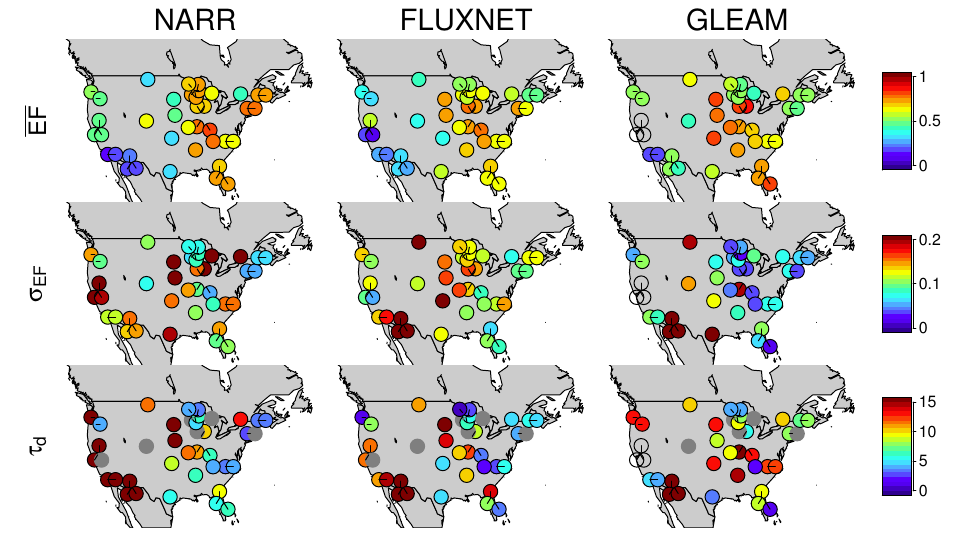
Figure 6. Statistical properties of EF data sets (NARR, FLUXNET, GLEAM, from left to right): (top) mean (EF), (middle) standard deviation ( σ EF ), and (bottom) decorrelation timescale ( τ d ). Only days with data in all three data sets are included in the computation. The decorrelation timescale τ d is computed following von Storch and Zwiers (1999). Grey dots indicate too many gaps for a reliable quantification of τ d . Empty dots for GLEAM indicate sites with unreliable NEXRAD